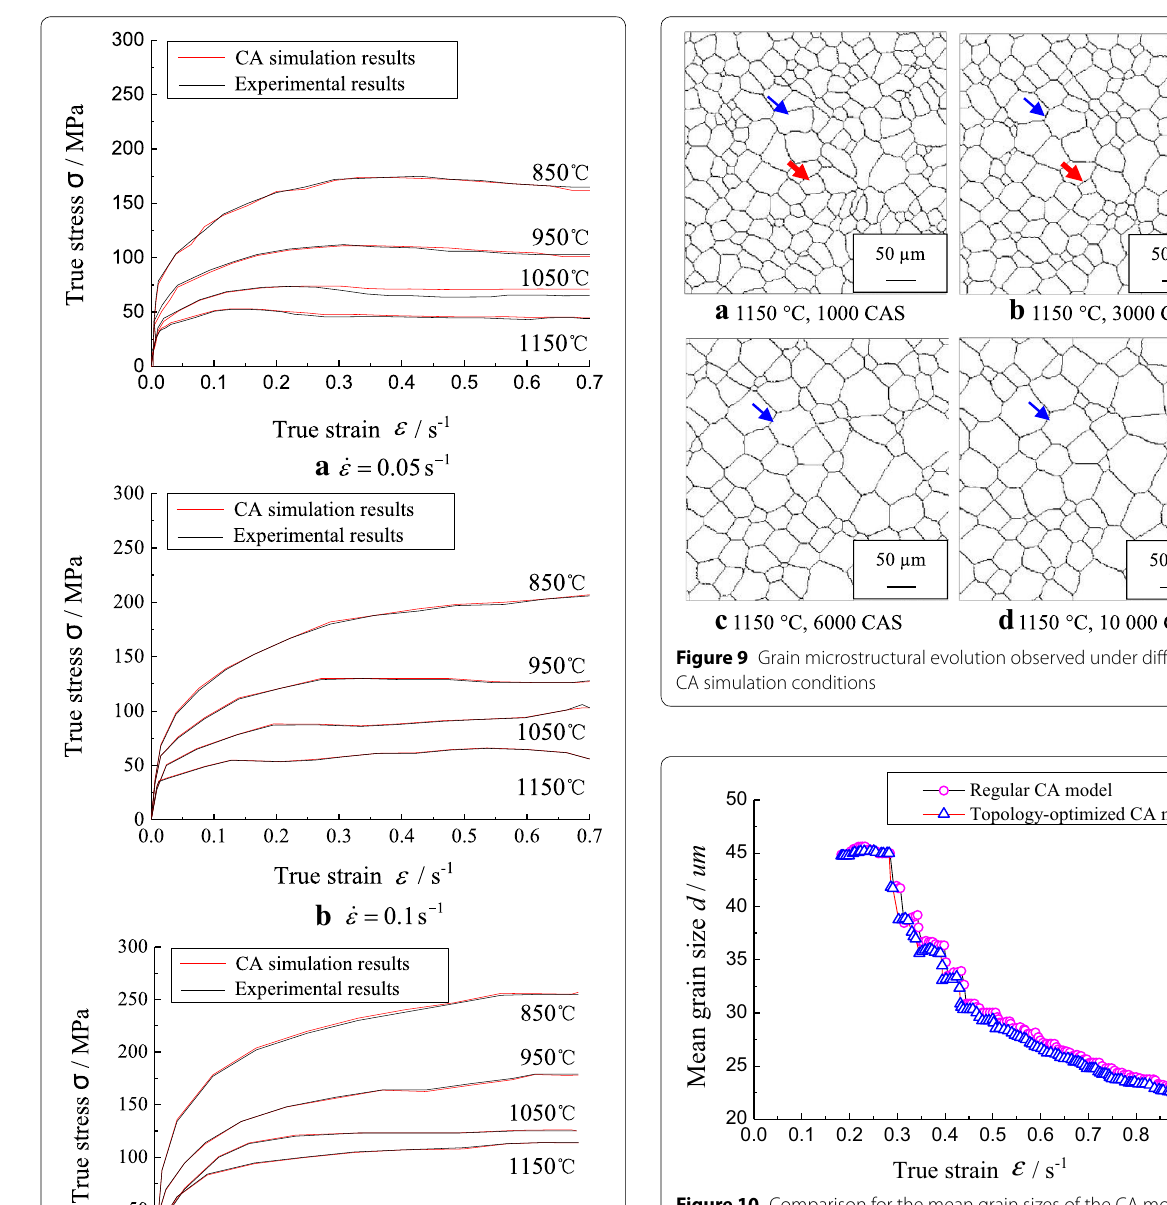
Figure 10 Comparison for the mean grain sizes of the CA